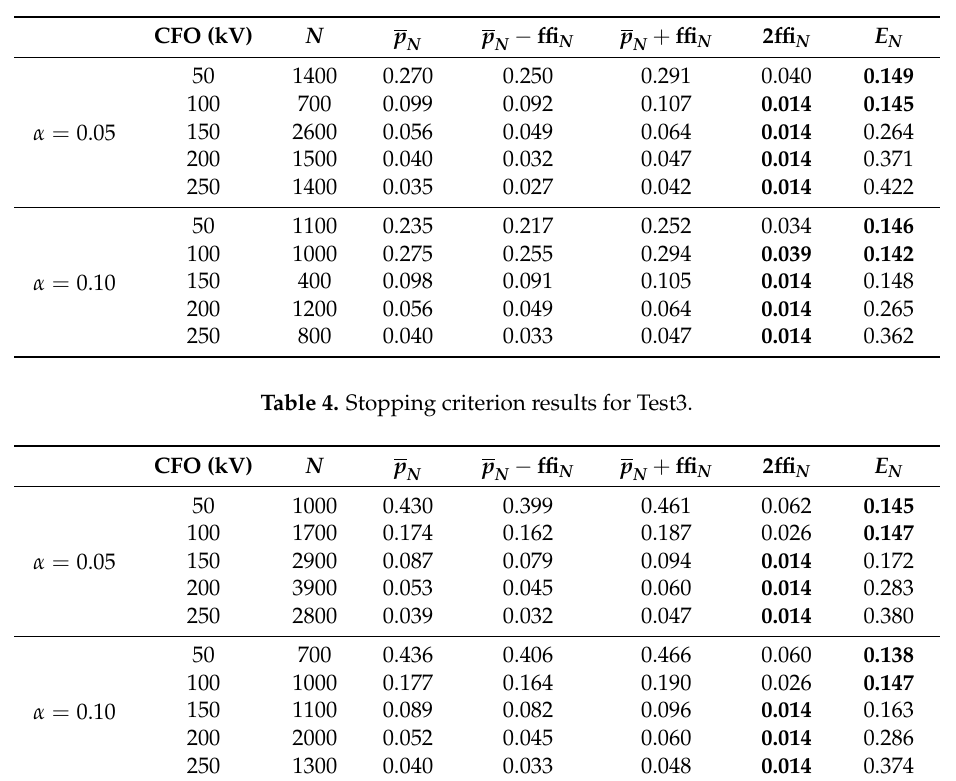
Figure 3. Graphical evolution of E N (Panel ( a ) and ( b )), δ N (Panel ( c ) and ( d )), confidence strip and p (Panel ( e ) and ( f )) as a function of N for CFO = 150 kV.